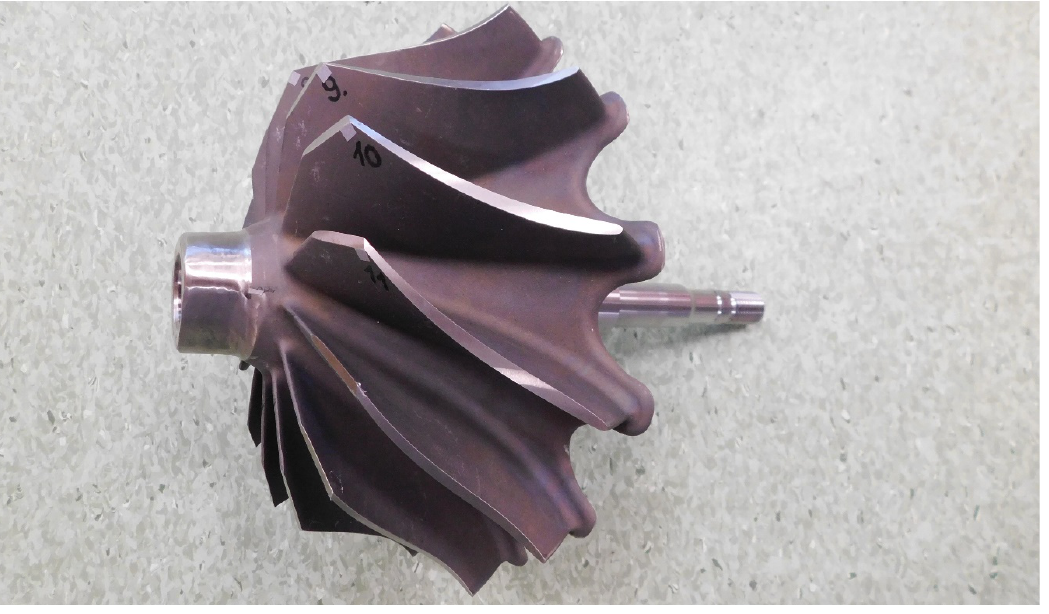
Figure 1. Marine engine turbocharger rotor.